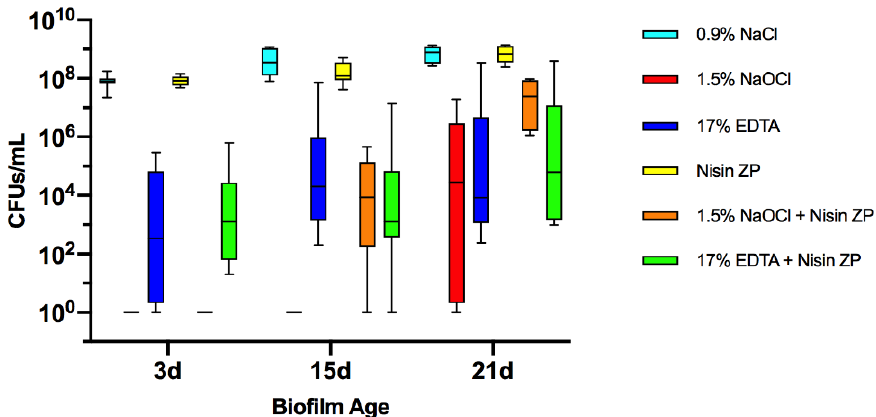
Figure 1. Boxplots demonstrating cell counts after 5 min treatments with 1.5% sodium hypochlorite (NaOCl); 17% EDTA; high-purity nisin (nisin ZP) and their associations on multispecies biofilms grown on hydroxyapatite disks for 3, 15 and 21 days. The internal line represents the median; the whiskers indicate minimum and maximum. Data derived from three independent experiments, each represented in triplicate biofilm cultures (n =